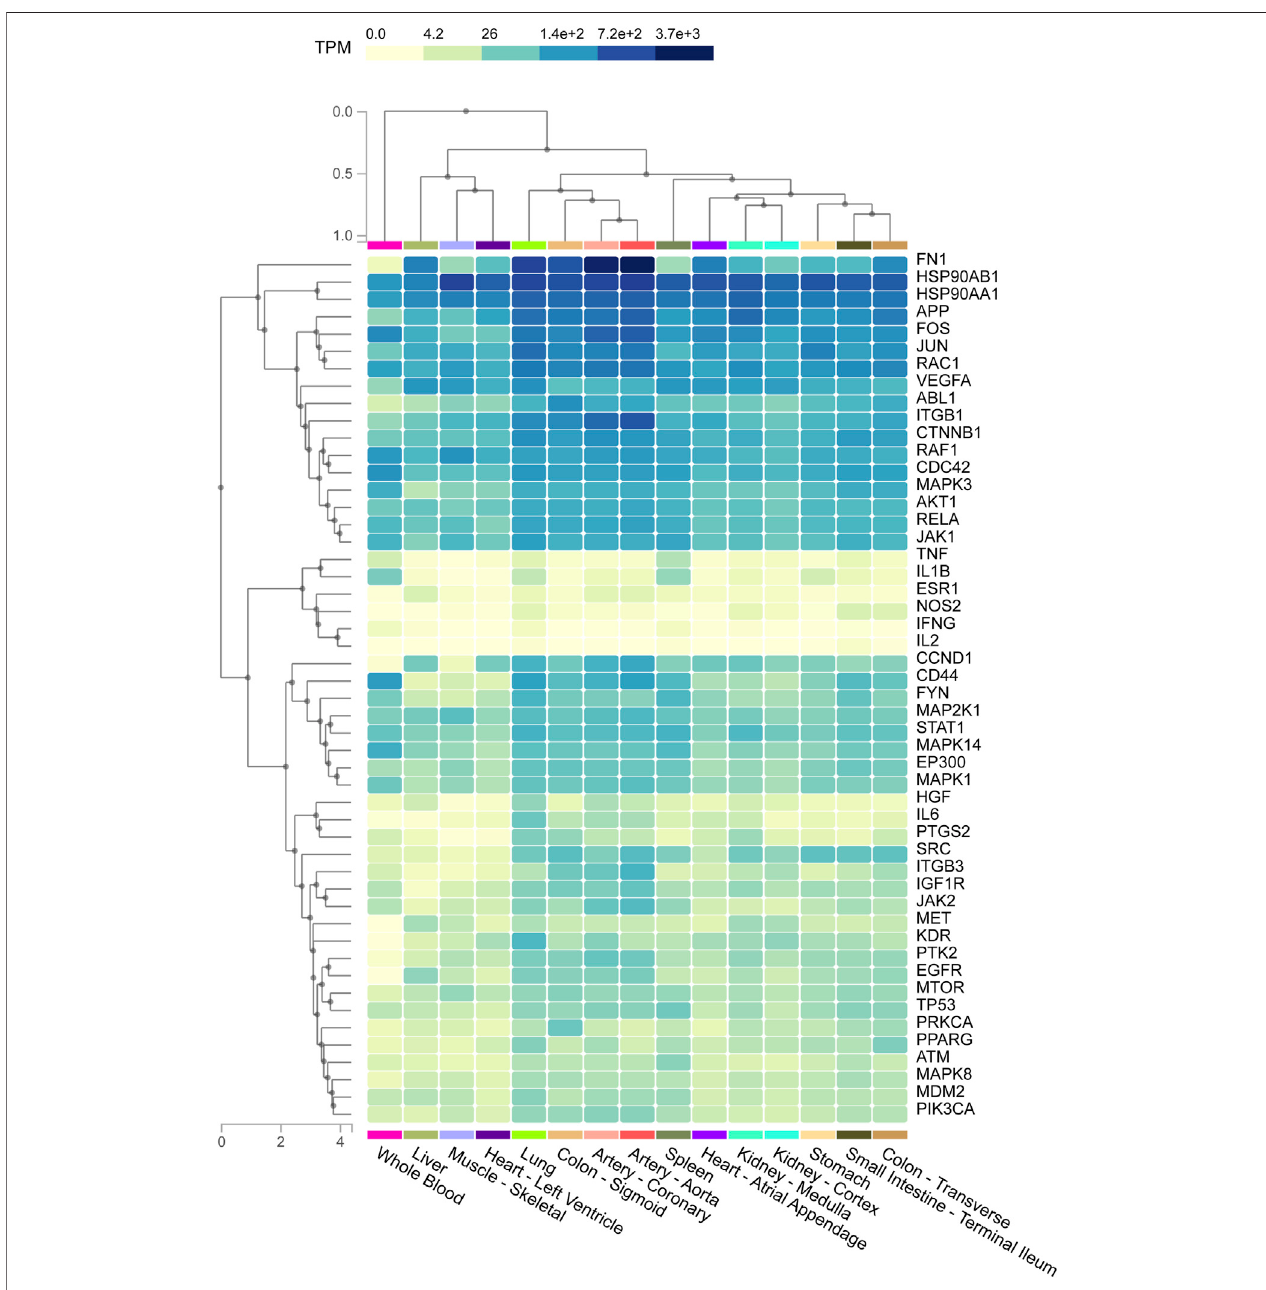
FIGURE 6 | The heat map shows the relationship between different tissue samples and critical targets. Column represents critical targets and row represents enrichedtissues.Theshadesofcolorsrepresentthelevelsofenrichmentofcriticaltargetsintissues,andthedarkerthecolorindicatesthemoresigni fi cantenrichmentof targets in corresponding